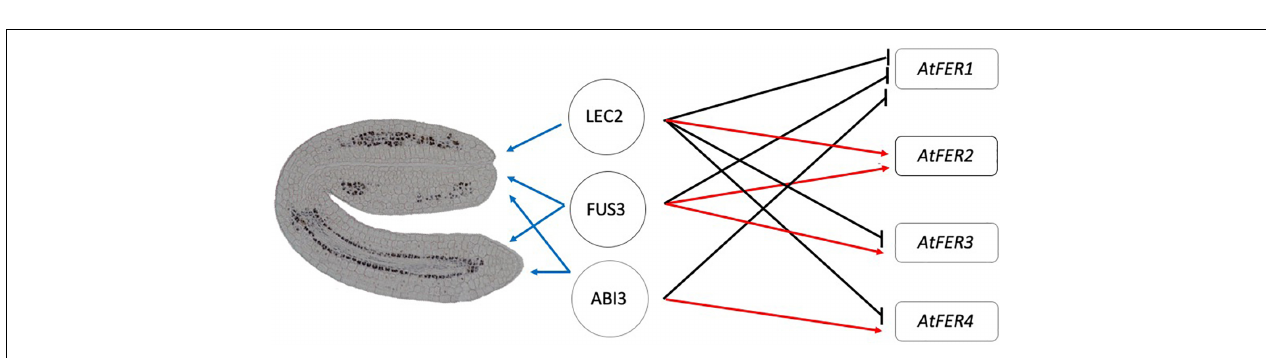
FIGURE 6 | Model involving LEC2, FUS3, and ABI3 transcription factors in iron embryo loading and FERRITINs gene expression. AtFER1 gene expression is negatively regulated by LEC2, FUS3, and ABI3. AtFER2 gene expression is positively regulated by LEC2 and FUS3. AtFER3 and AtFER4 are positively regulated by FUS3 and ABI3, and negatively regulated by LEC2. LEC2 is involved in iron loading in cotyledons, whilst FUS3 and ABI3 are involved in iron loading in whole embryo. Black arrows, negative regulation; Red arrows, positive regulation; Blue arrows, where transcription factor acts in the